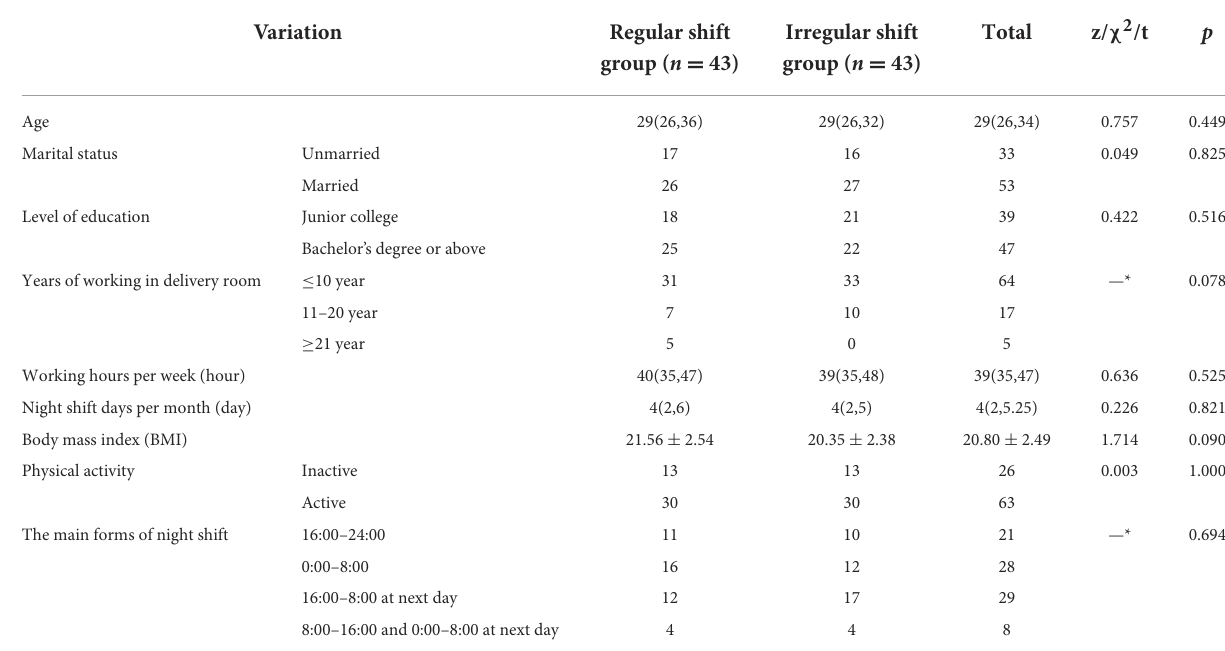
TABLE 1 Demographic data of study